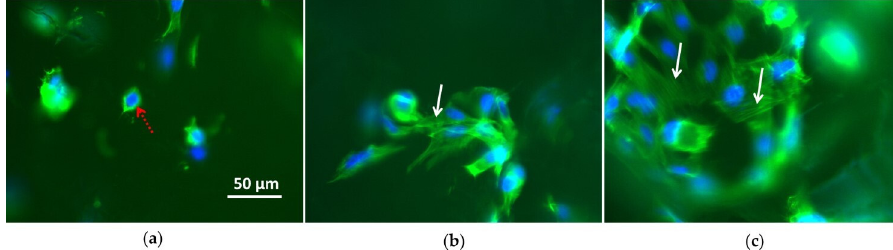
Figure 9. Fluorescence microscopy images of Saos-2 cells cultured for 17 h on ( a ) control; ( b ) H 2 O/Mg2.5/absorbent; and ( c ) H 2 /Mg15.8 scaffolds. Atto488 phalloidin was used to observe the actin cytoskeleton (green), while DAPI dye was used to stain cell nuclei. White arrows show actin stress fibres. The dotted red arrow shows the perinuclear actin on Saos-2 cells grown on native scaffolds.